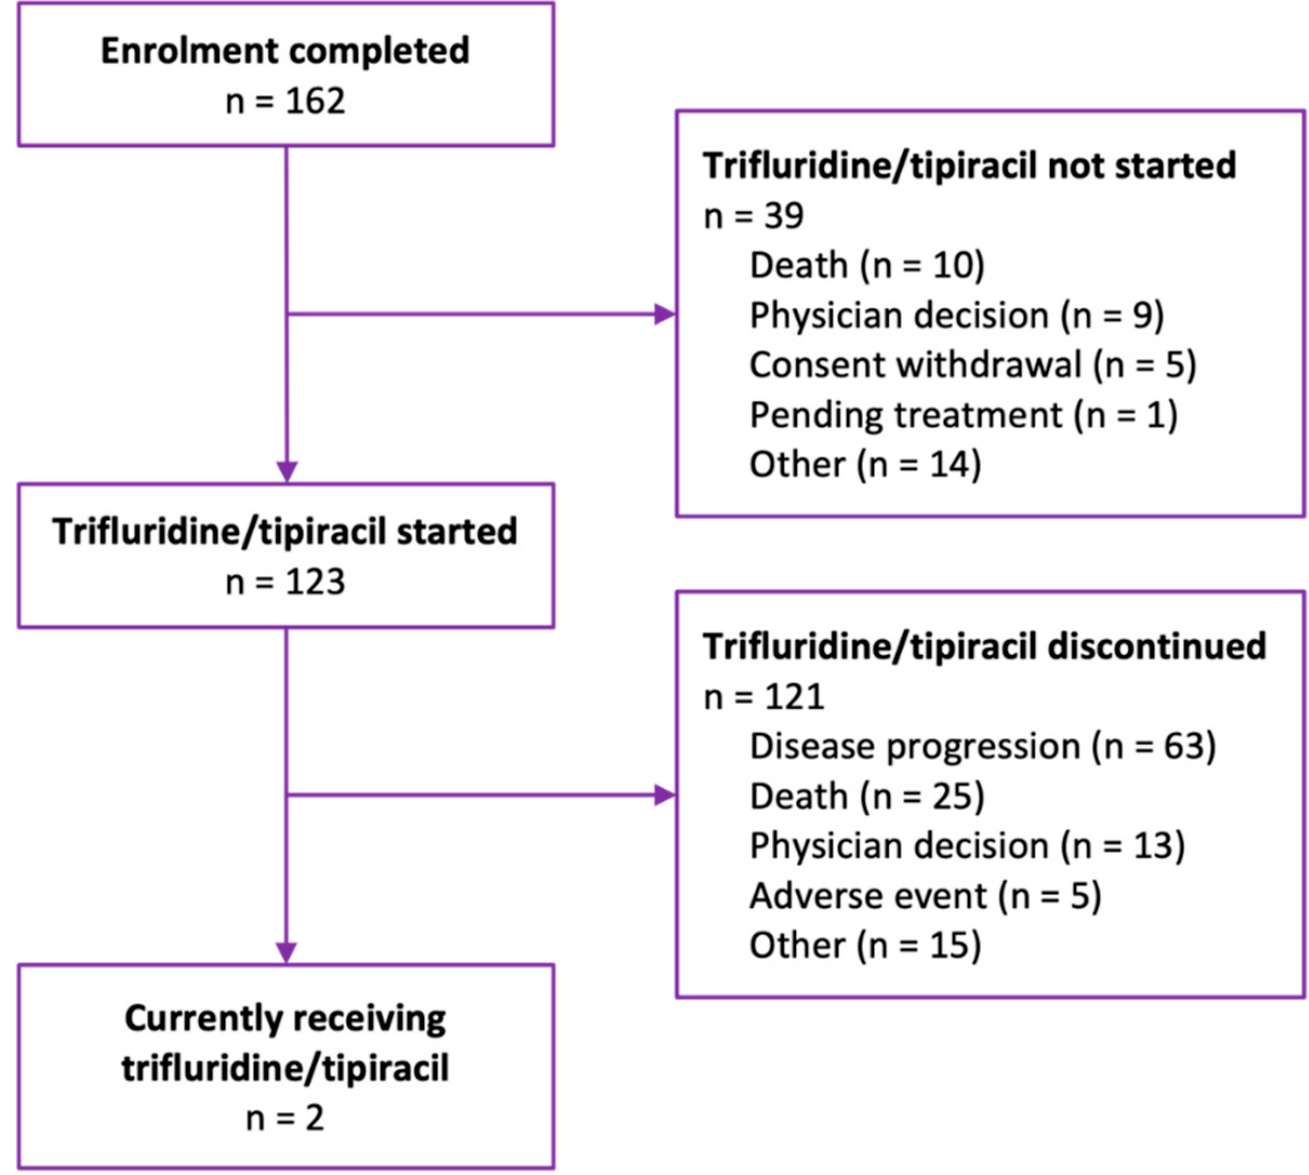
Figure 1. Flow diagram of patients enrolled in Taiho Pharma Canada’s Patient Support Program to receive trifluridine/tipiracil for metastatic gastric/gastroesophageal cancer.